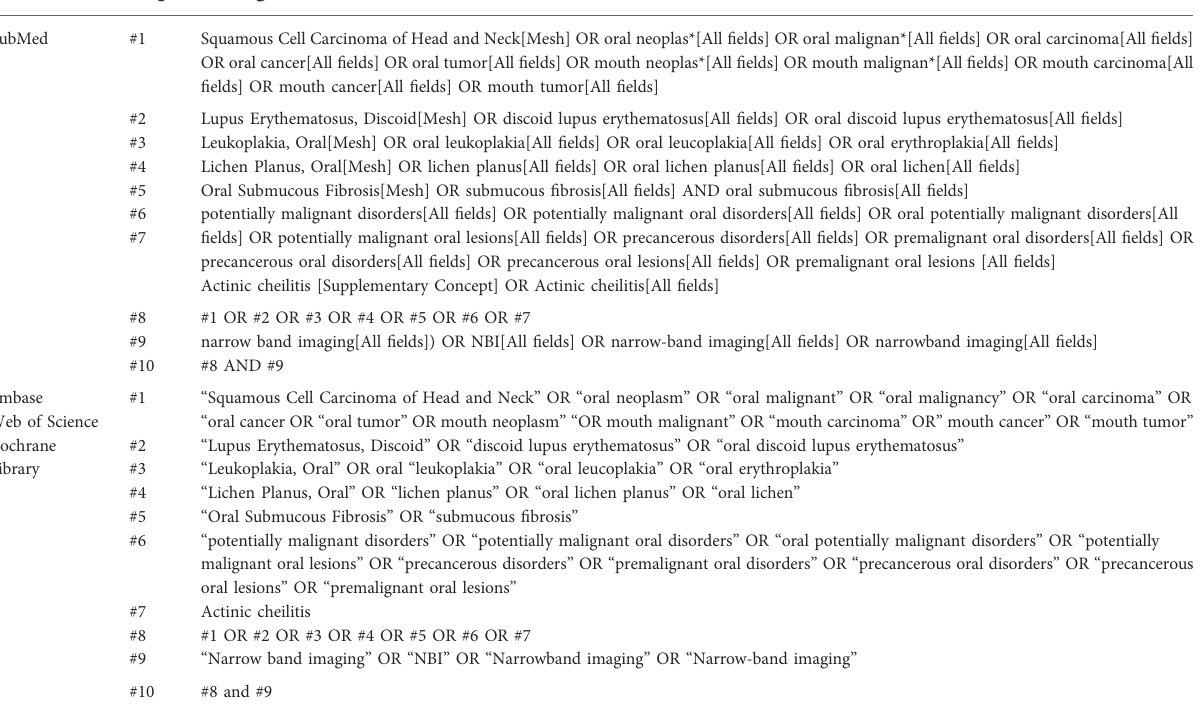
TABLE 1 Search strategies of the study.